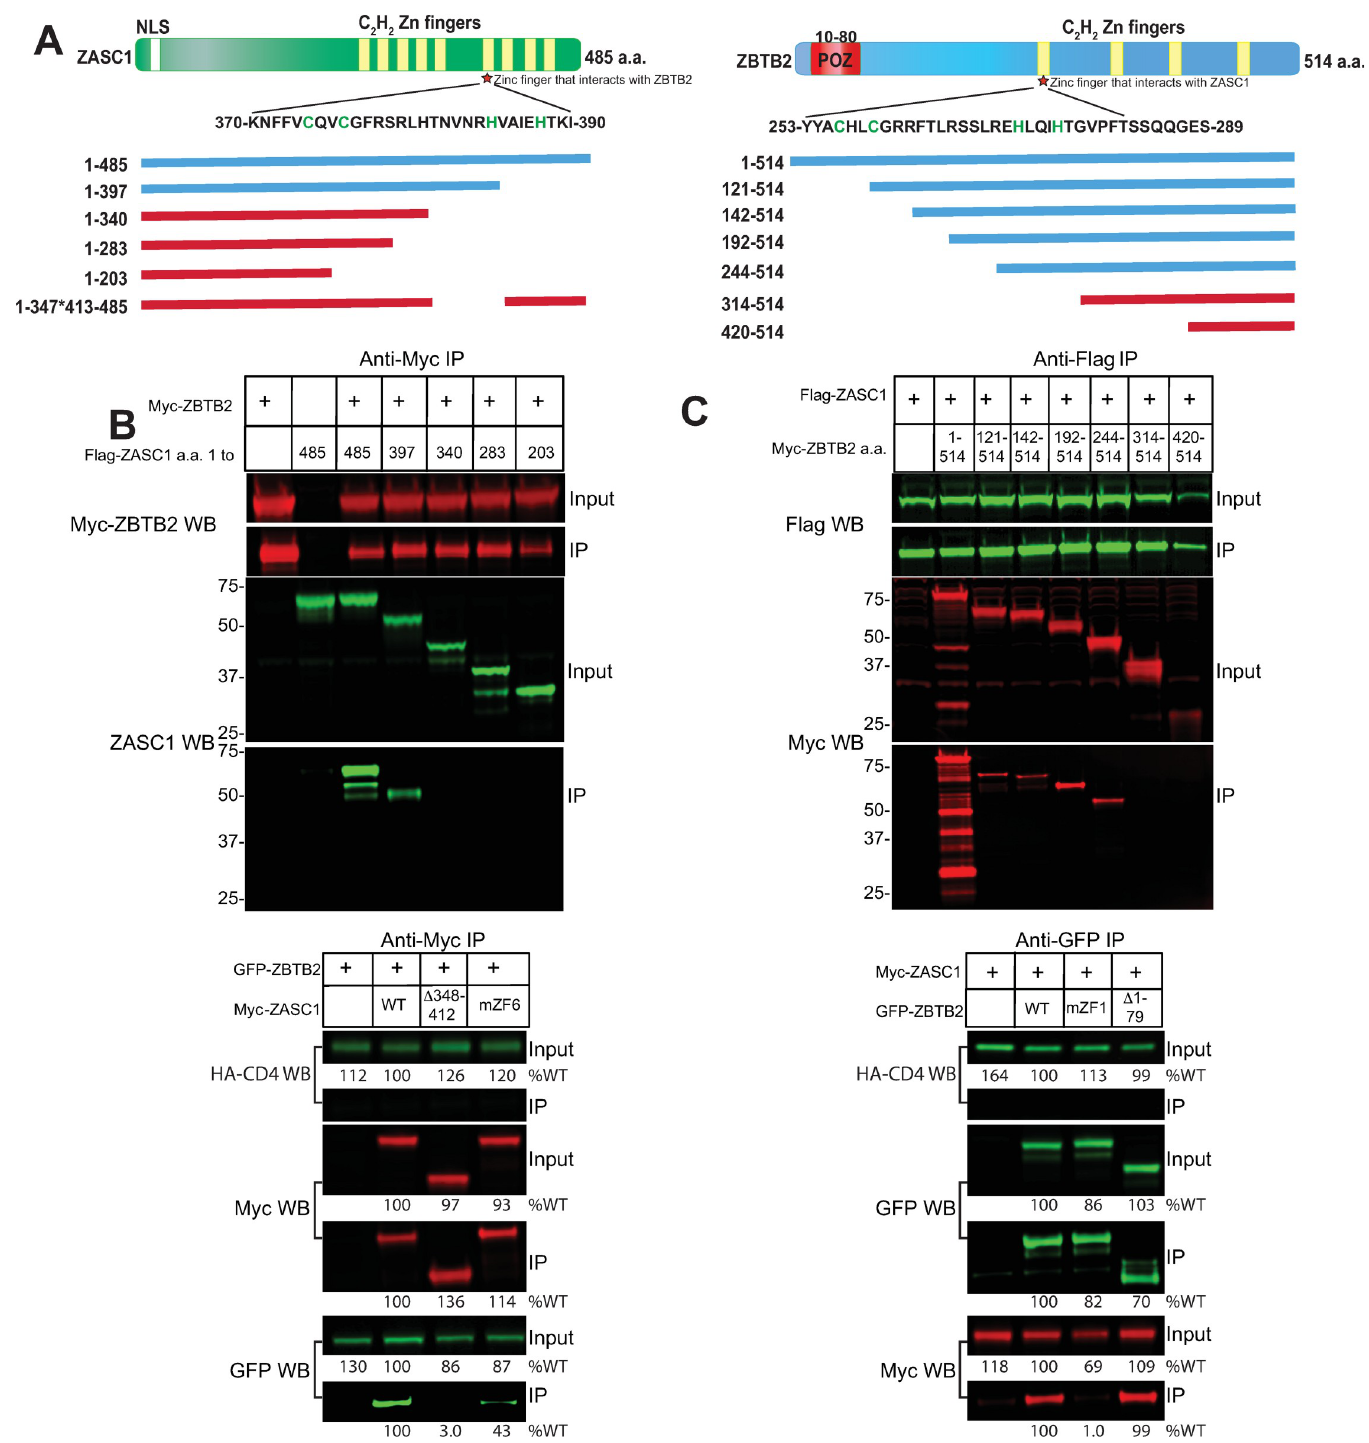
Fig 1. ZASC1 and ZBTB2 interact. (A) Schematic of ZASC1 and ZBTB2 and relative location of N-terminal and internal deletion variants tested for interaction. Blue indicates interaction and red indicates a failure to interact. The location of zinc fingers in each protein are indicated in yellow. Sequences of the interaction domains in ZASC1 zinc finger 6 (ZF6) and ZBTB2 zinc finger 1 are shown below the respective protein maps, with Cys and His residues implicated in Zn 2+ coordination indicated in green. The ZASC1 mZF6 variant has C376, C379S,H392A, H397A mutations while the ZBTB2 mZF1 variant has C256S, C259S, H272A, H276A mutations. HEK293 cells (1X10 7 ) were transfected with expression plasmids encoding the epitope tagged forms of the indicated proteins. 48 h post-transfection, cells were lysed, and epitope tagged proteins were immunoprecipitated (IP). Starting material and IP material was separated by SDS-PAGE and analyzed by western blotting (WB) using the indicated